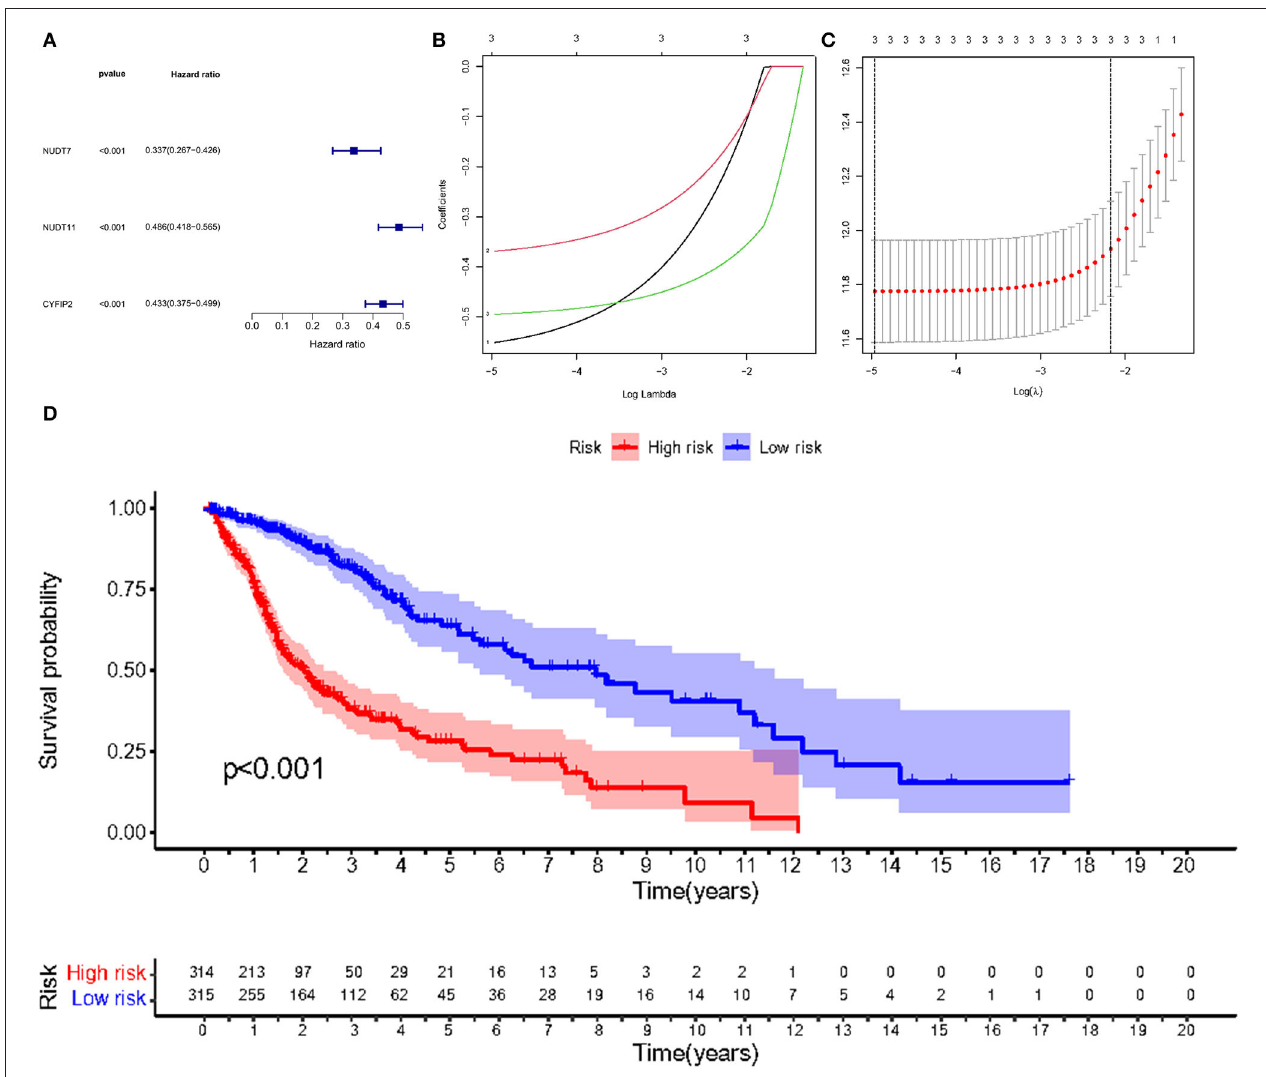
FIGURE 6 | Risk signature with three m7G RNA methylation regulators. (A) Univariate Cox regression analysis of the m7G RNA methylation regulators. (B, C) LASSO regression analysis was used to calculate the coefficients of the three m7G RNA methylation regulators. (D) Glioma patients were divided into low- and high-risk groups based on the median risk